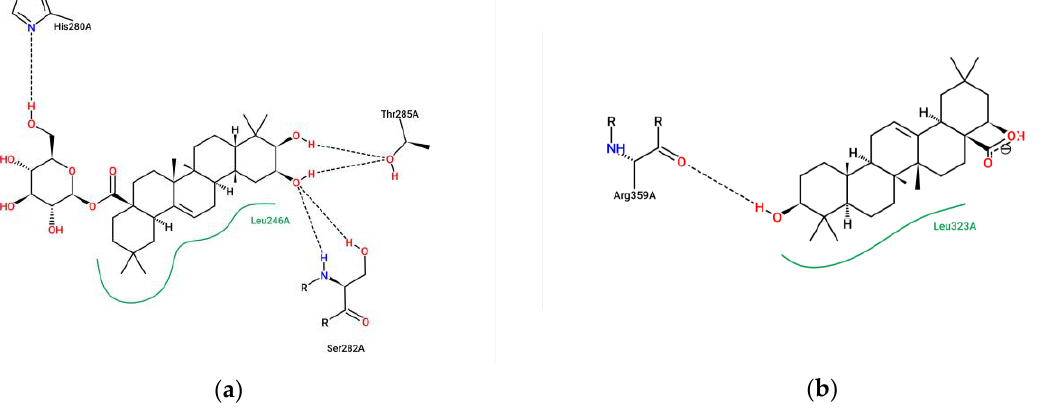
Figure 10. The 2D interaction diagram of the docking poses of compounds 3 ( a ) and 13 ( b ) on α -glucosidase of 3A4A.